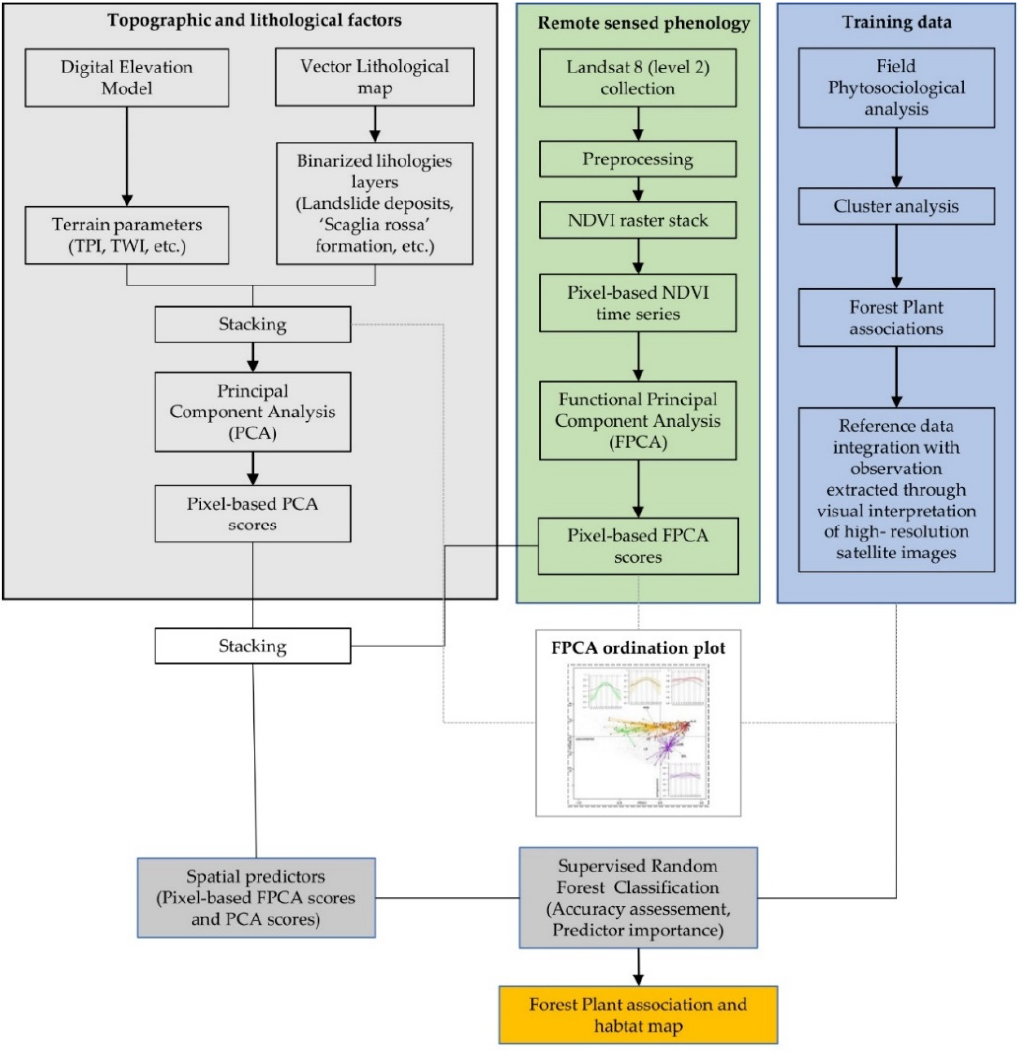
Figure 2. Workflow of the Mediterranean forest plant association mapping based on the Functional Principal Component Analysis of the Landsat 8 NDVI time series and